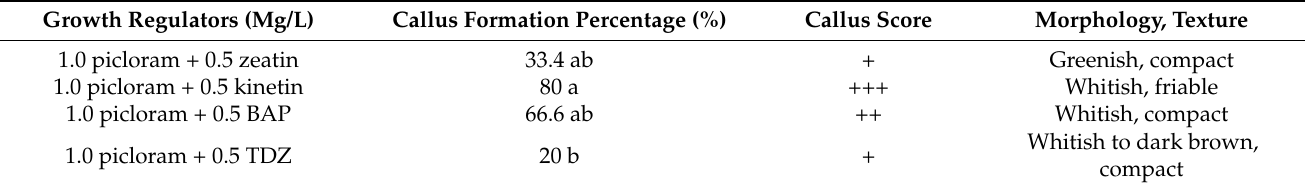
Table 4. The effects of 1.0 mg/L picloram and 0.5 mg/L different cytokinins on callus induction percentage of leaf explant of Labisia pumila var. alata after 4 weeks of culture. Growth Regulators